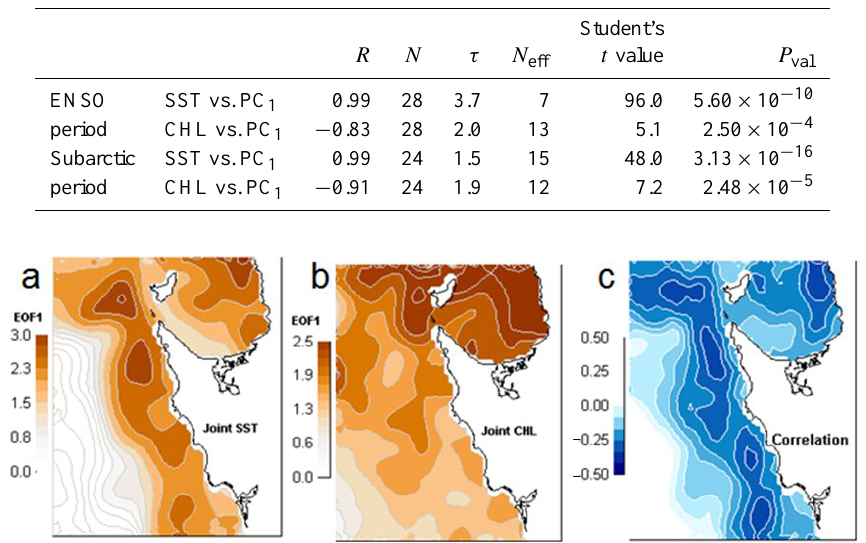
Figure 4. Spatial patterns for mode 1 of the joint EOF analyses of (a) SST, (b) Chlorophyll a (accounting for 80% of the total variance) and (c) correlation map between monthly anomalies of SST and Chlorophyll a . The largest negatives correlations (< −0.2, the blue areas) are seen along the coast and coincide with the high joint EOF 1 scores (>2.0) of SST (a). Absolute correlations above, R crit ( P<0.05 ) = 0.211, (i. e. the strongest negative correlation) are significant at the 95% confidence level.